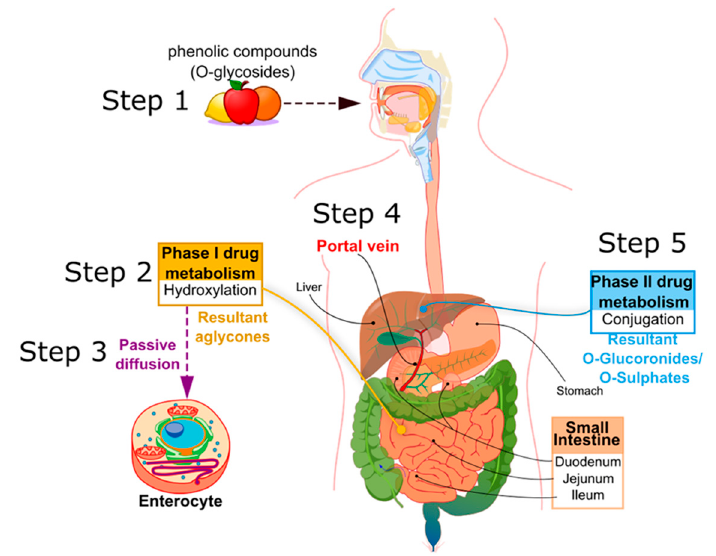
Figure 2. Principle metabolic steps of dietary phenolic compound (PC) in humans.